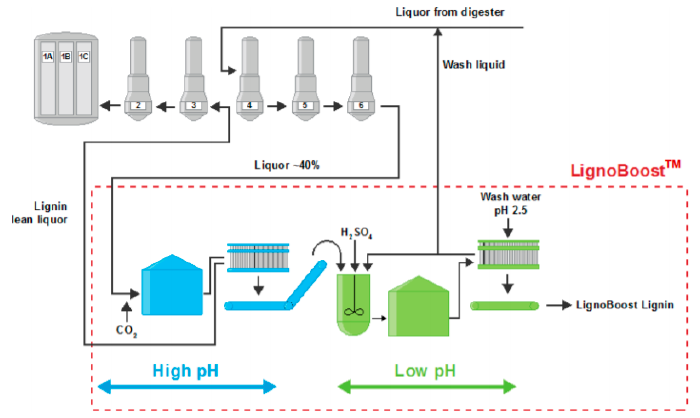
Figure 1. LignoBoost process by Stora Enso.